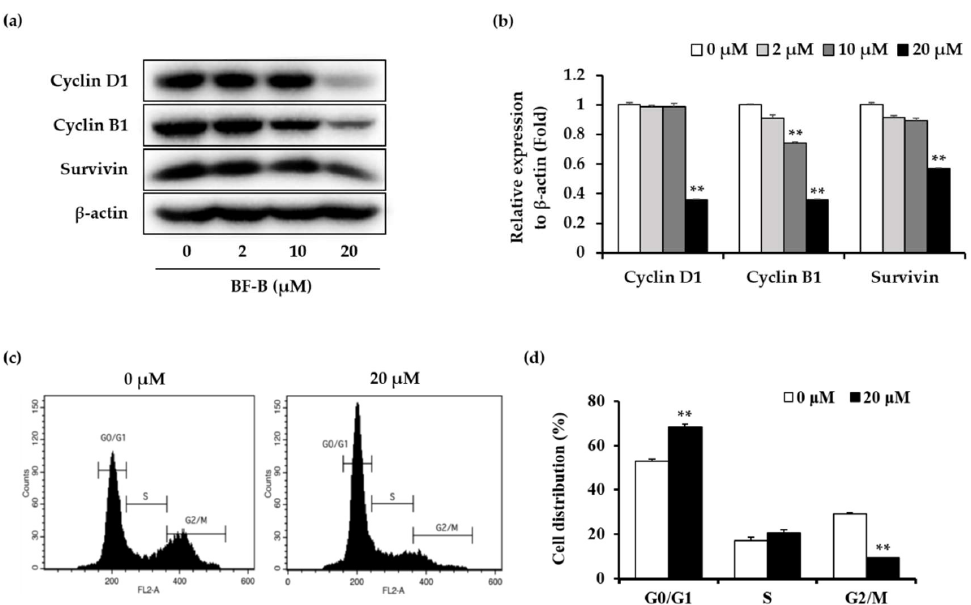
Figure 4. E ff ect of BF-B on FoxM1 target gene expression and cell cycle phase distribution in PANC-1 cells. ( a ) PANC-1 cells were treated with the indicated concentrations of BF-B for 24 h, and protein levels of cyclin D1, cyclin B1, and survivin were detected by Western blotting and ( b ) each protein levels were quantified using Image J software. ** p < 0.001 as compared to control. ( c ) PANC-1 cells were treated with 20 μM of BF-B for 24 h. Cell cycle distribution was assessed by flow cytometric analysis. ( d ) The cell population in each stage of the cell cycle was determined using BD CellQuest Pro software. All data are expressed as means ± SD of three experiments and each experiment included triplicate repeats. ** p < 0.001 as compared to control of each group.